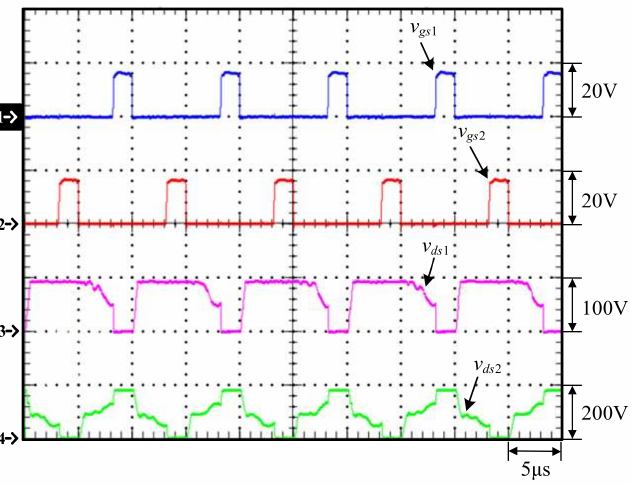
Figure 23. Measured waveforms relevant to 25% of the rated load: (1) v gs 1 ; (2) v gs 2 ; (3) v ds 1 ; (4) v ds 2 .